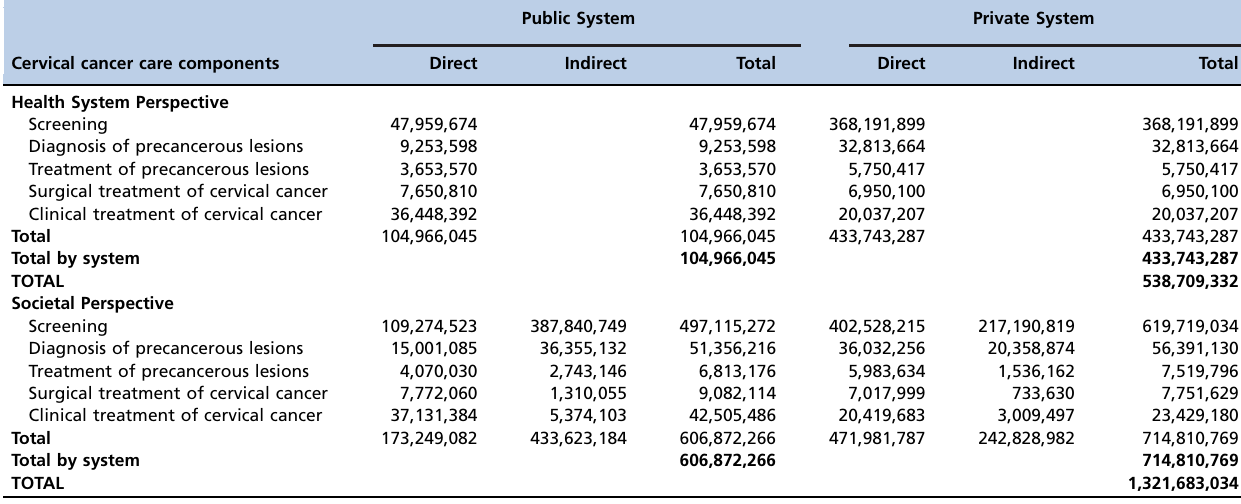
Table 4 - Total annual costs of prevention and treatment of cervical cancer in Brazil according to health system, in 2006 United States dollars.